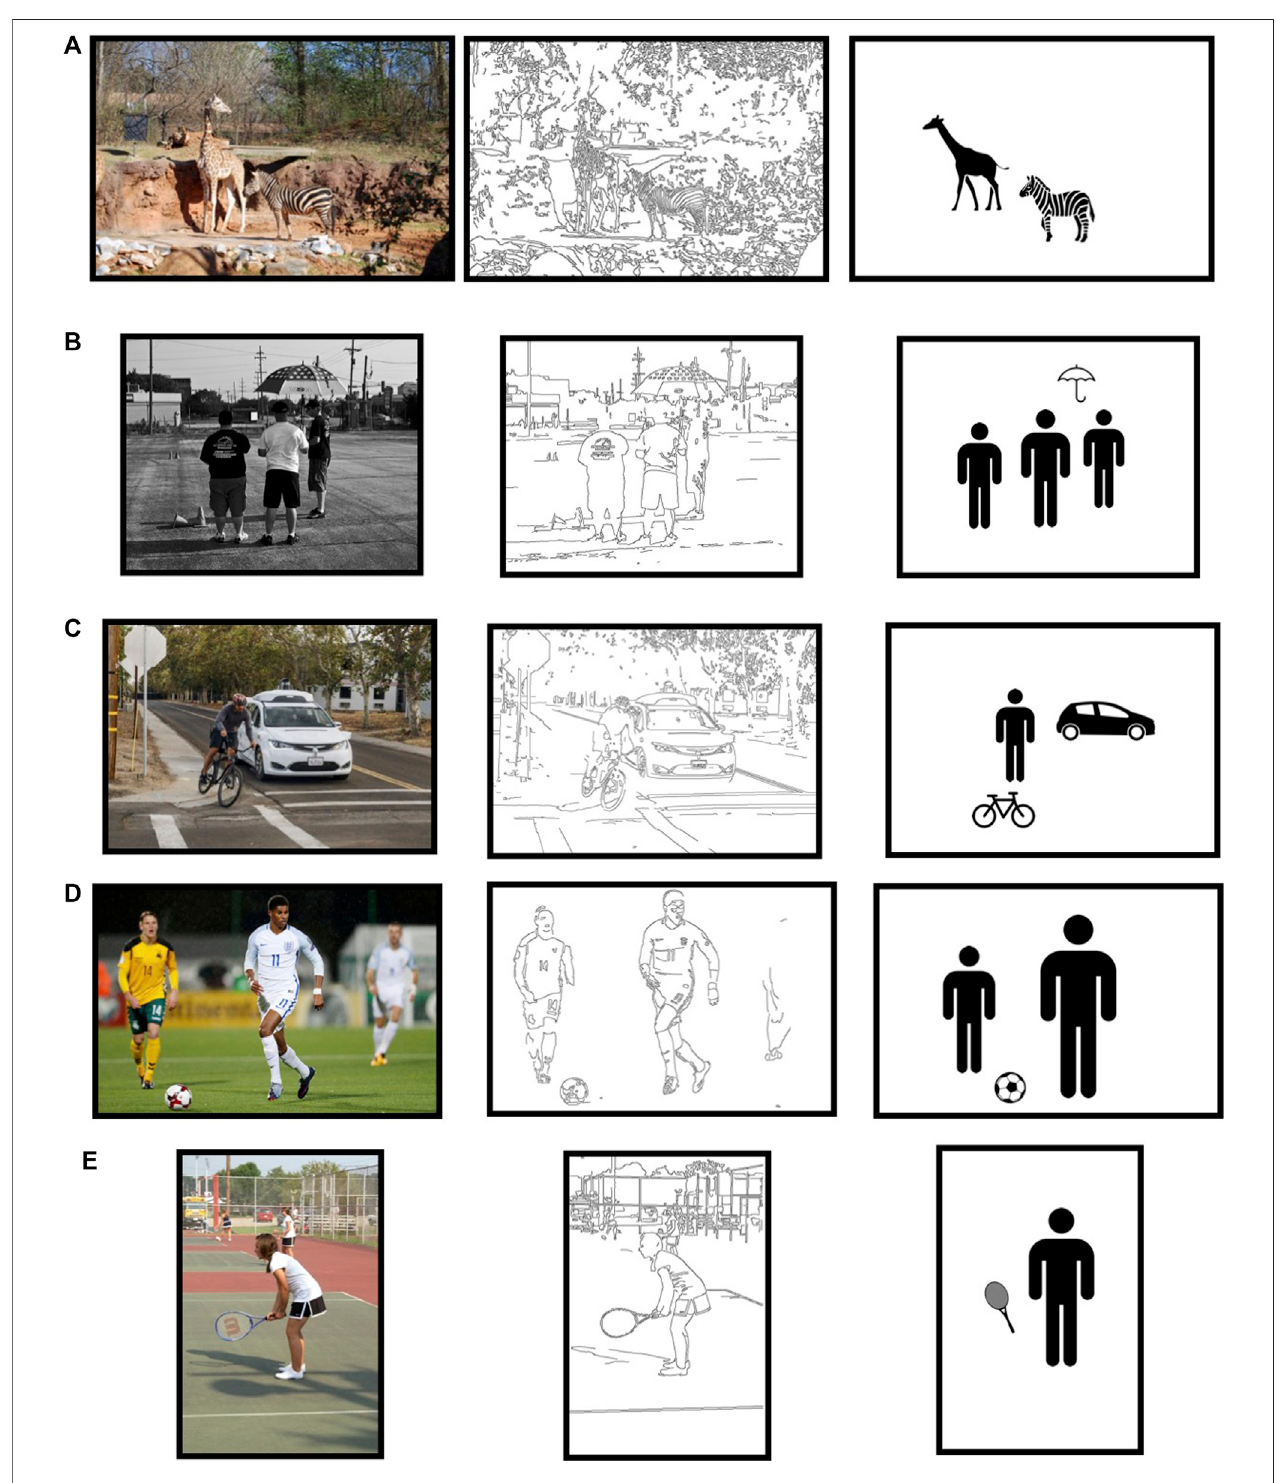
FIGURE 3 | Examples of photographs being represented as an edge map or using icons only.